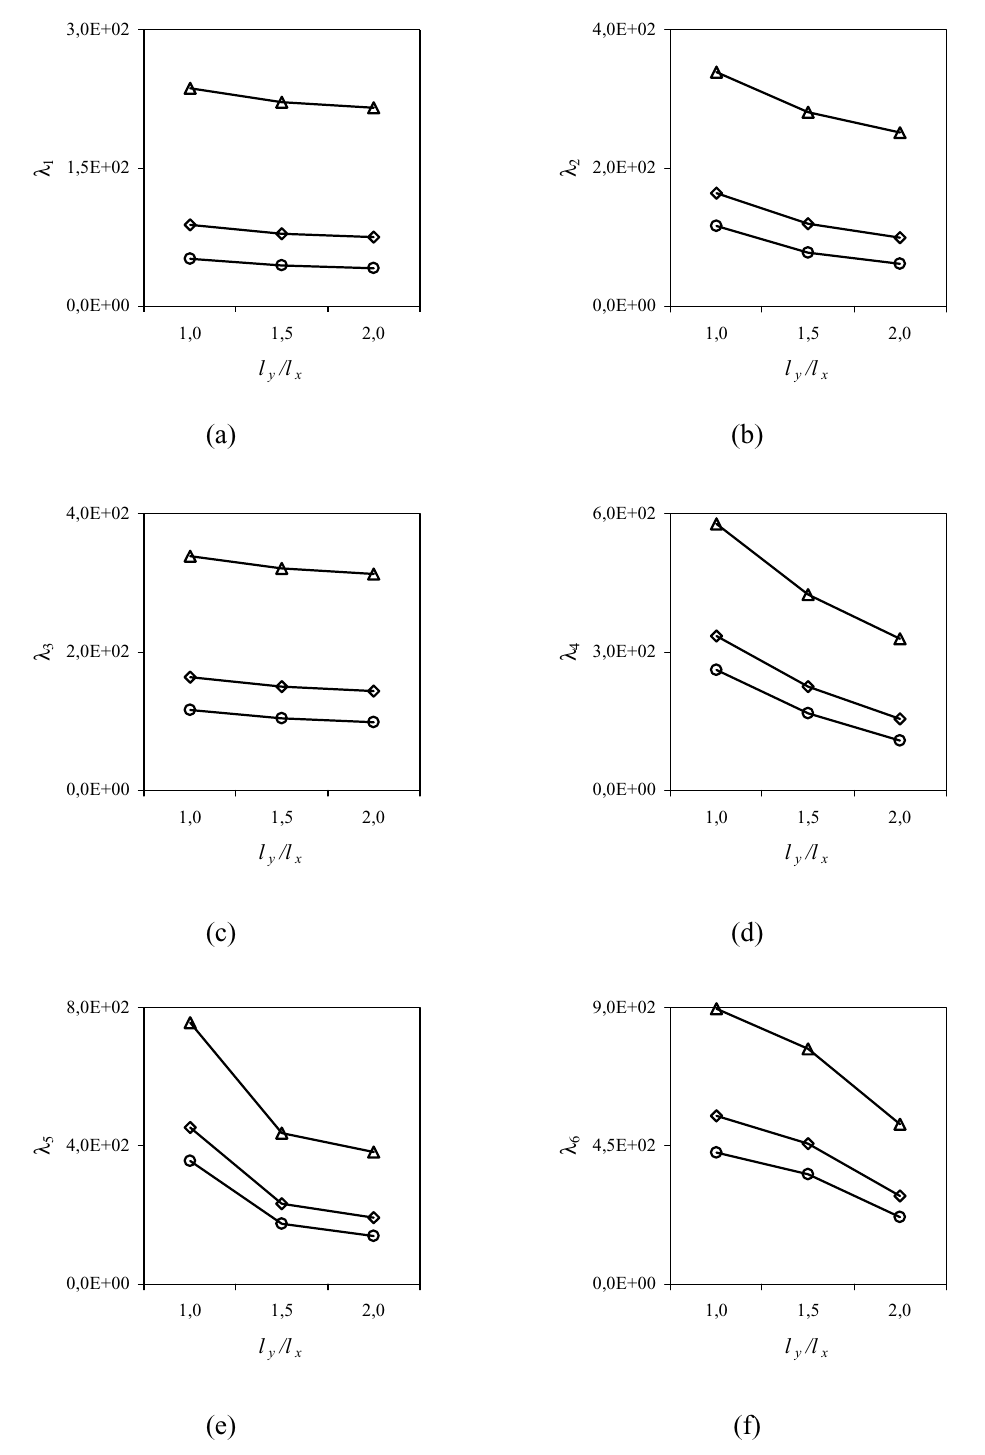
Fig. 4. The variation of the first six frequency parameters of the plate on elastic foundation with various values of l y /l x ratio and H for γ = 3 . – ∆ –, H = 5 m; – ♦ –, H = 10 m; –o–, H = 15